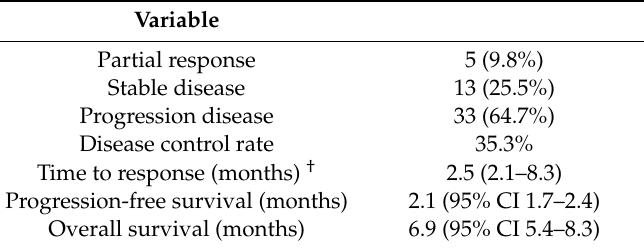
Table 2. Clinical outcomes.